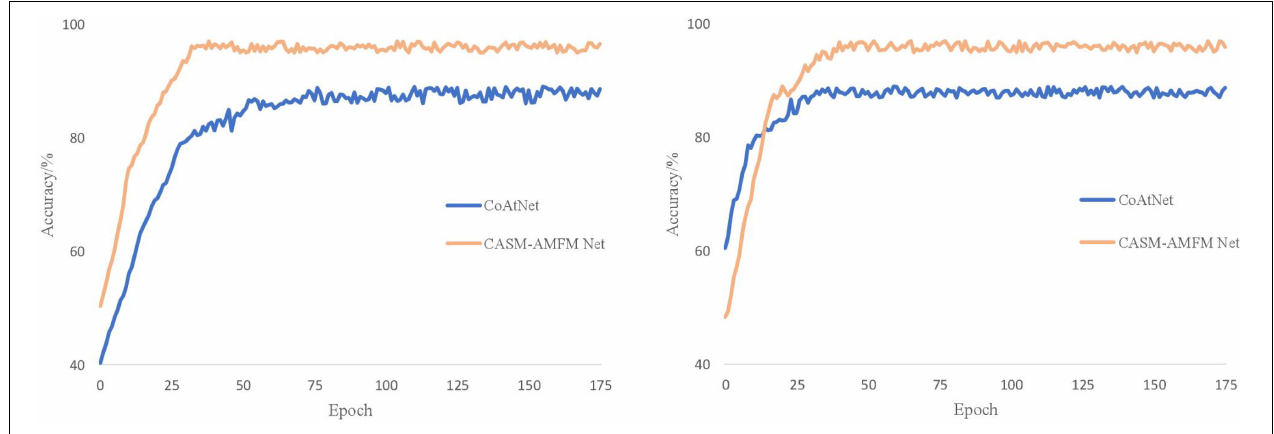
FIGURE 8 | Accuracy curves of the CoAtNet and the coordinated attention shuffle mechanism-asymmetric multi-scale fusion module net